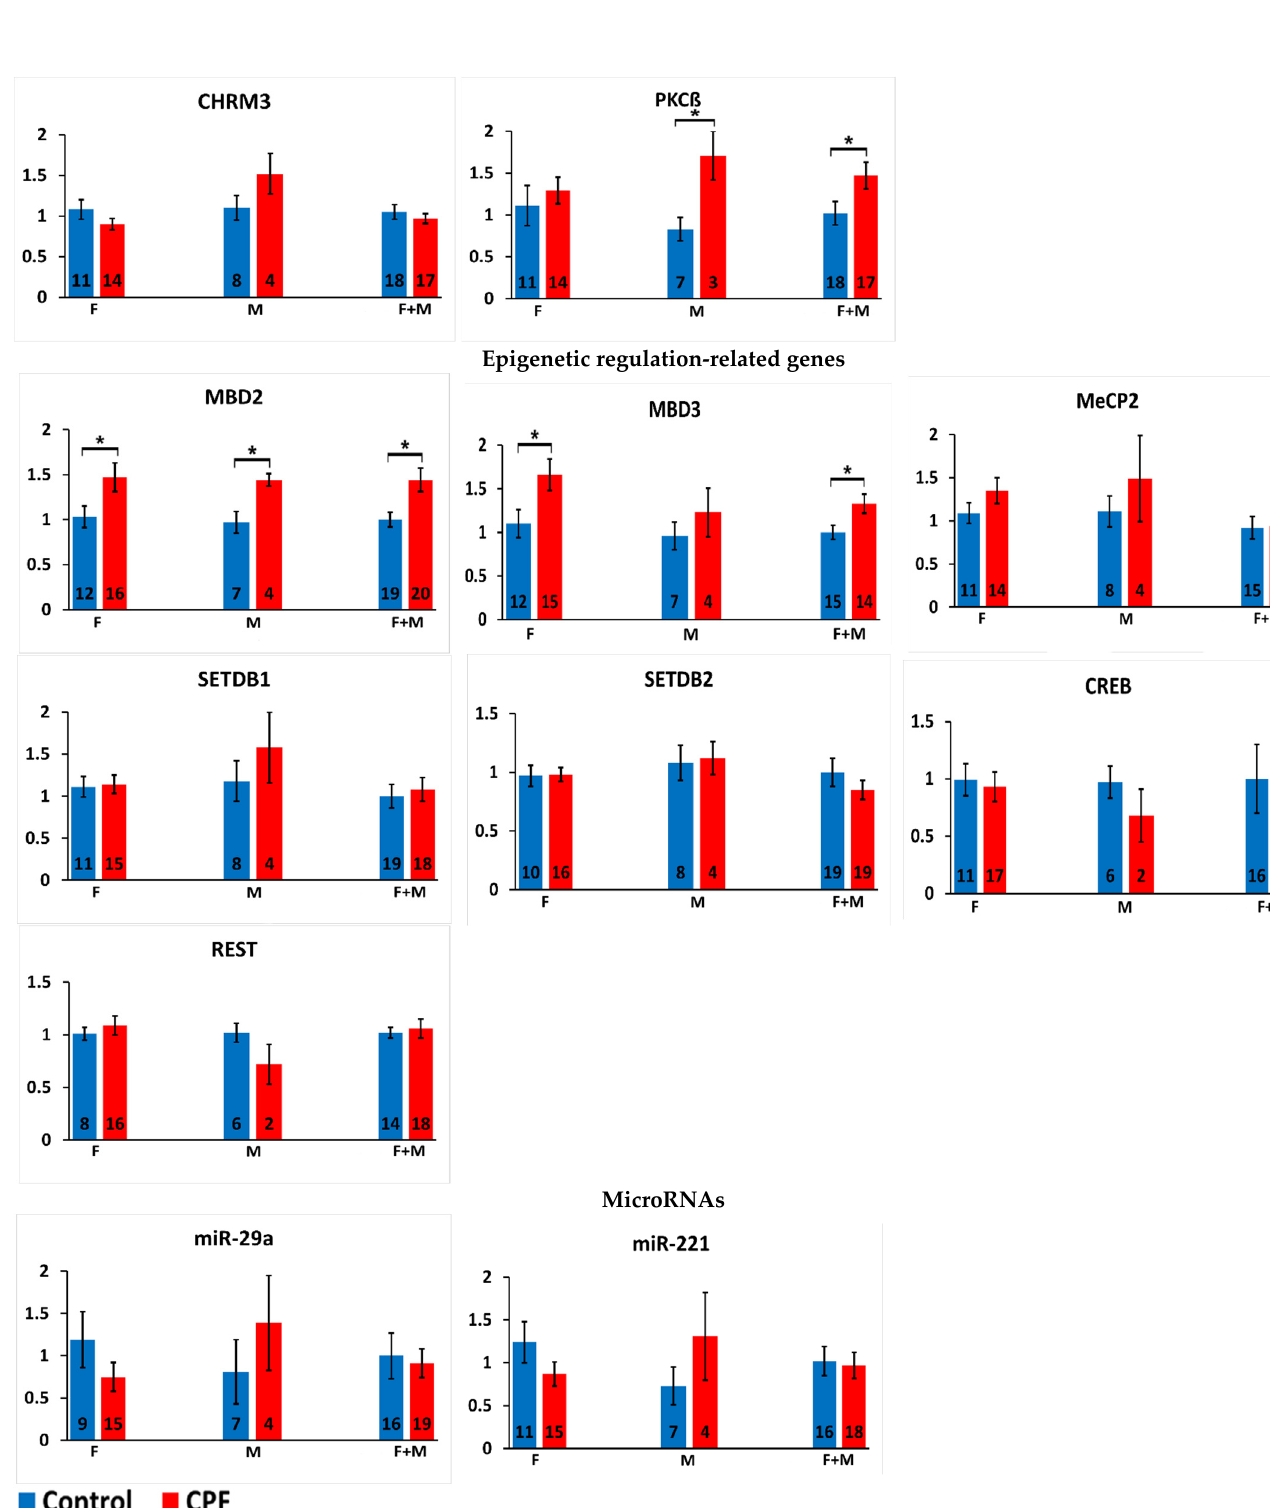
Figure 3. Effects of pre-hatch exposure to chlorpyrifos (CPF) on the offspring’s gene expression. Relative gene expression results obtained in the offspring after pre-hatch exposure to chlorpyrifos. M: male offspring, F: female offspring. Number of samples (n) is presented inside each column. Results are presented as the mean ± SEM. #: PKCß, which is related to both neurogenesis and neutransmission genes, is presented in the neurotransmission section. *: p < 0.05. For genes abbreviations, please refer to Figure 1.